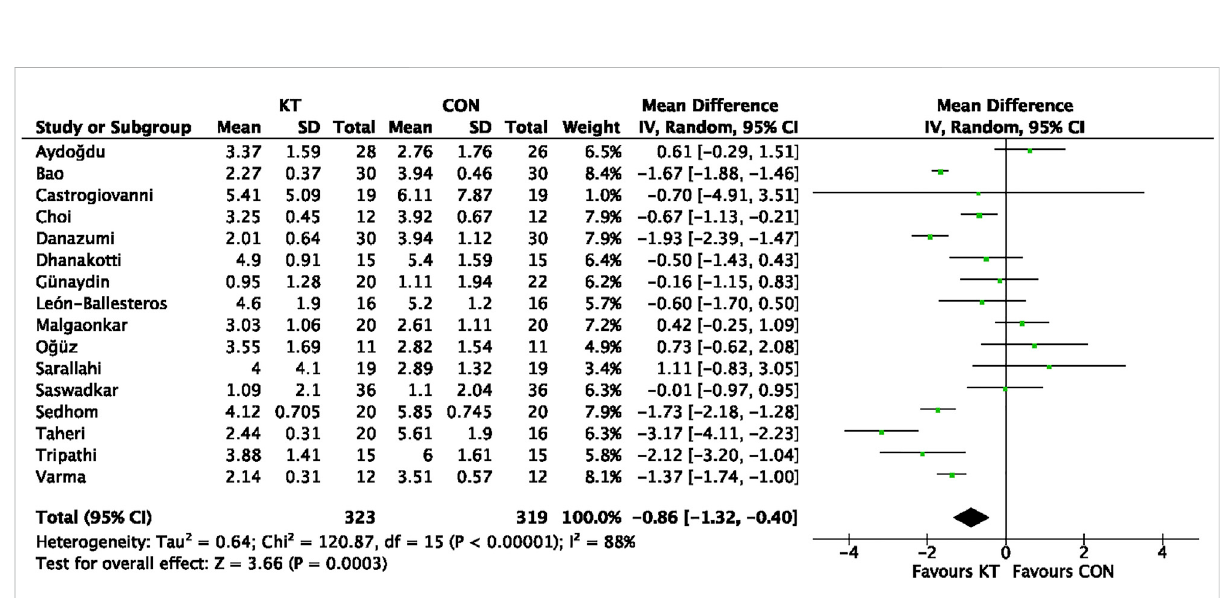
FIGURE 5 Forest plot of the meta-analyses comparing the KT group with control group for VAS score after